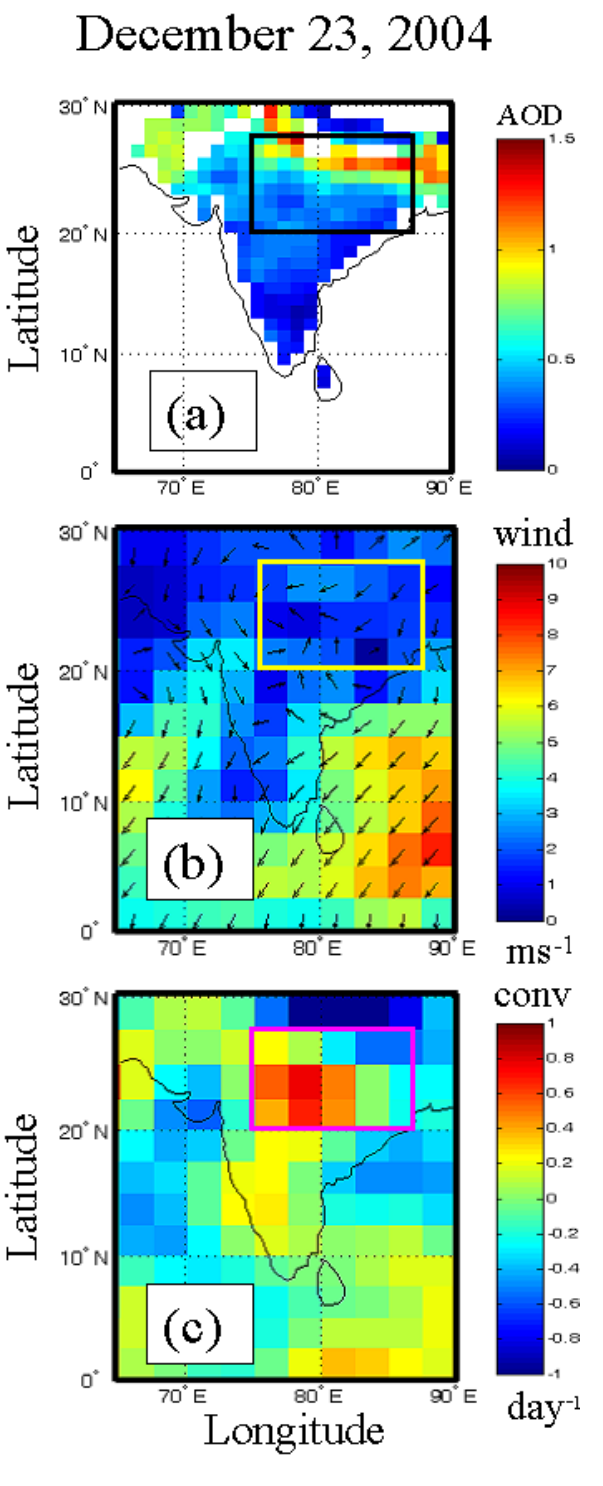
Fig. 4. Spatial distribution of MODIS derived AOD (a) NCEP re- analysis wind field at 925hpa (b) and NCEP derived wind conver- gence at 925hpa (c) on 23 December 2004.